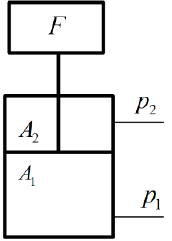
Figure 3. Mechanical model diagram of the hydraulic